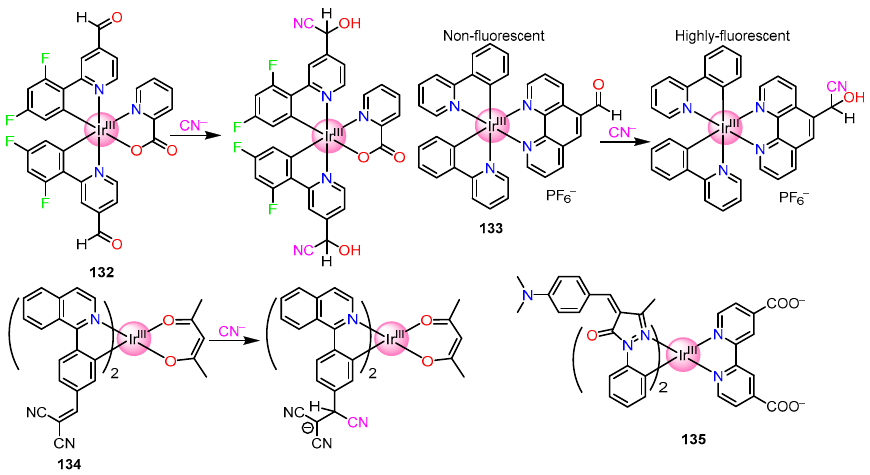
Figure 18. Structures of Ir(III) complexes 132 – 135. Yao group reported a cyclometallated phosphorescent complex of iridium,